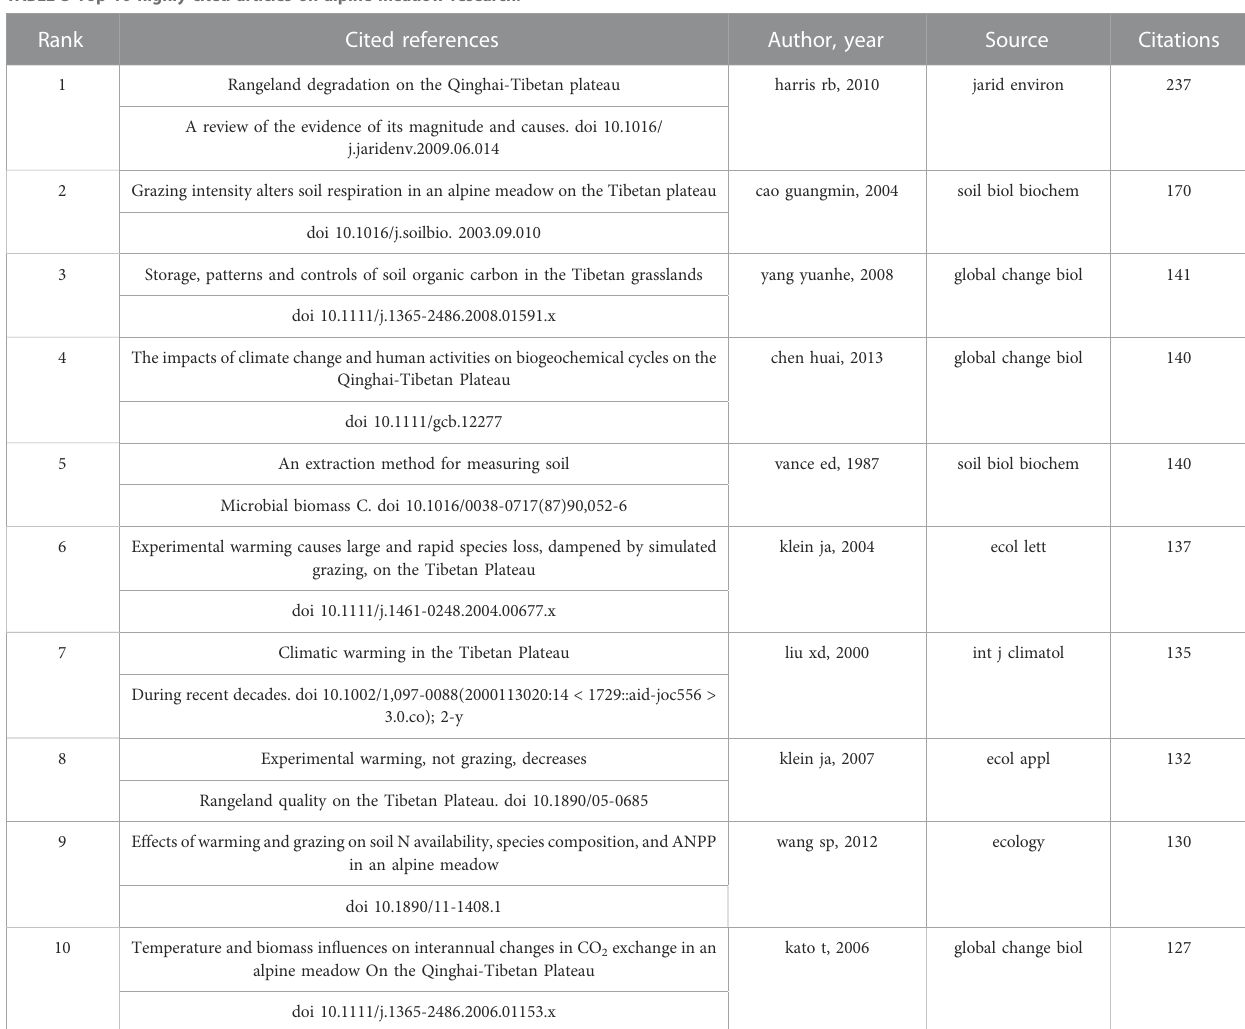
TABLE 3 Top 10 highly cited articles on alpine meadow